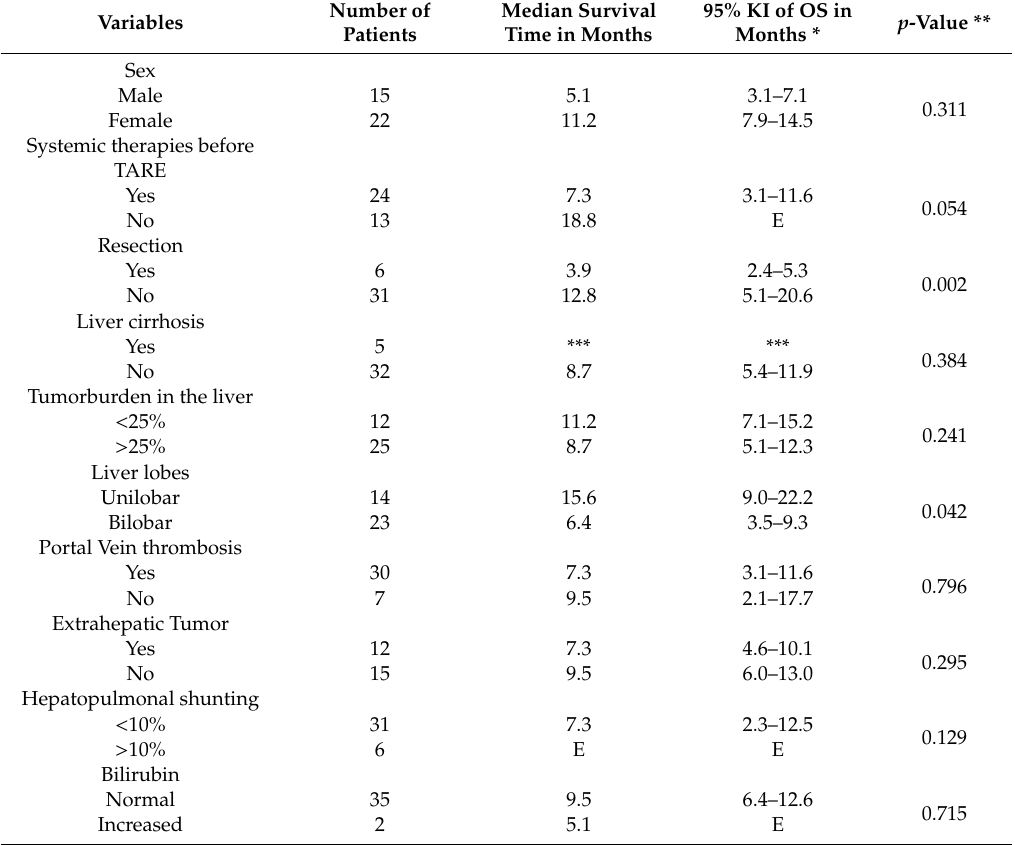
Table 6. Overall survival after TARE in dependence of pretherapeutic variables.